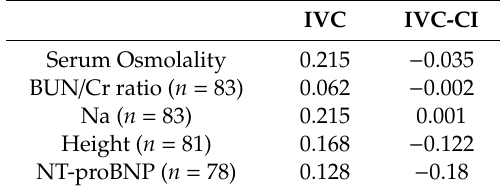
Table 5. Correlation coe ffi cient between IVC and related